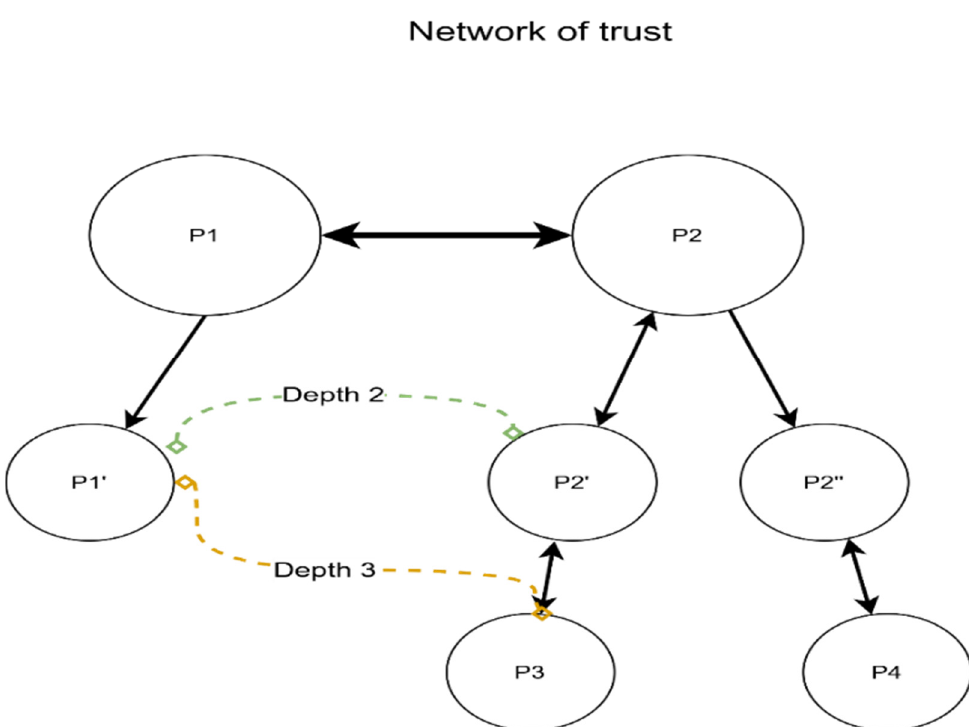
Figure 11. Network of trust, a directed graph.